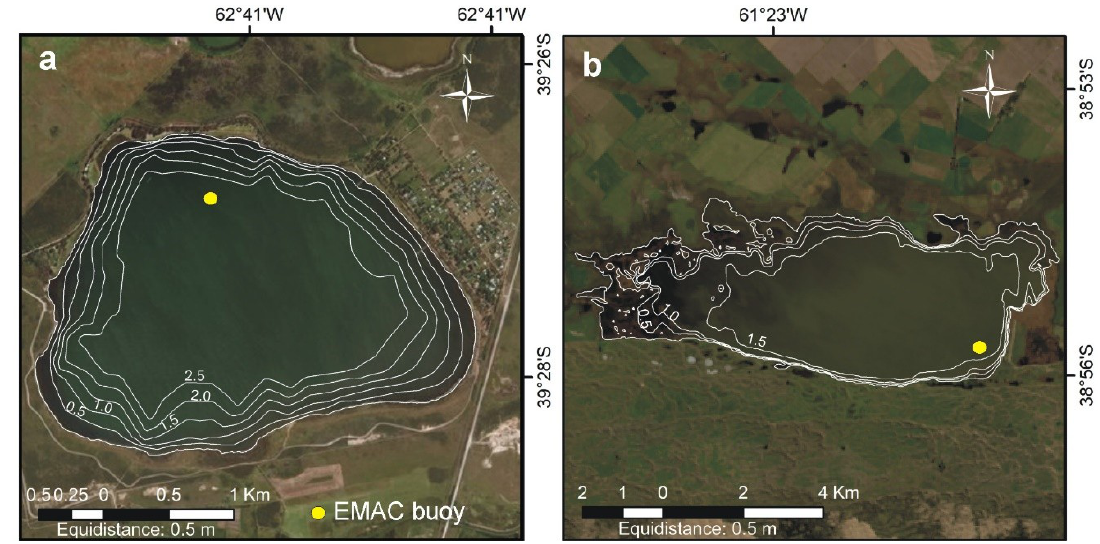
Figure 2. Map with isobaths in meters and location of the Estación de Monitoreo Ambiental Costero ( EMAC ) buoy in the: ( a ) La Salada and ( b ) Sauce Grande lakes.